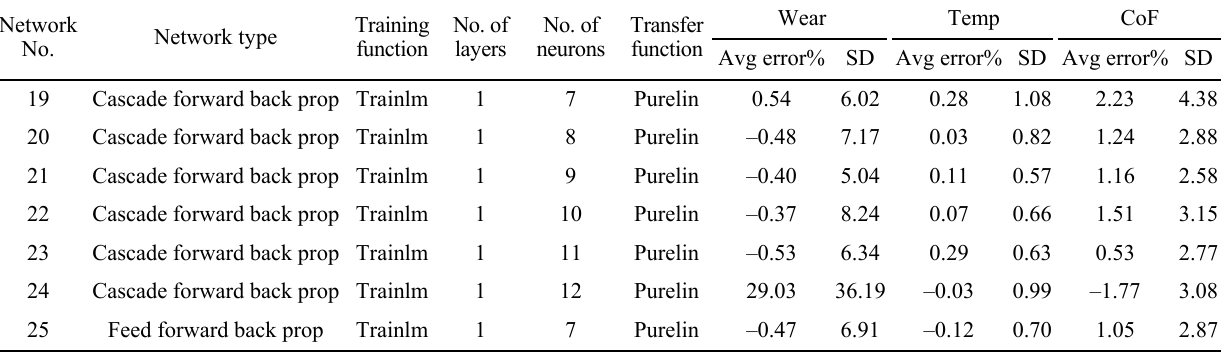
Fig. 11 Average total error% of wear for SHL-ANN architecture (Network Nos. 1 − 18). Table 17 Optimizing the network type and number of neurons in single hidden